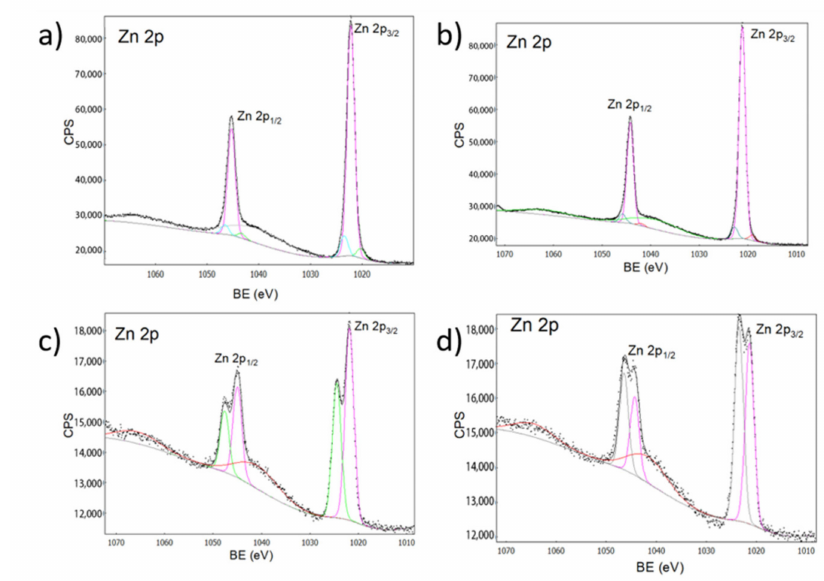
Figure 5. XPS spectra for zinc. ( a ) ZnO, ( b ) Zn-Ca 1, ( c ) Zn-Ca 3, ( d ) Zn-Ca 5.